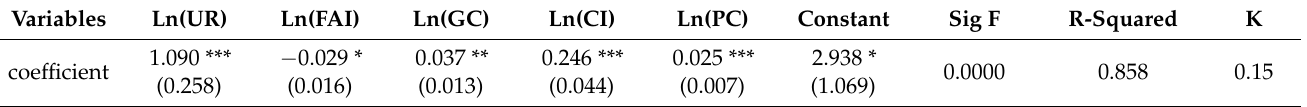
Table 5. Ridge Regression Estimation Results of Beijing.